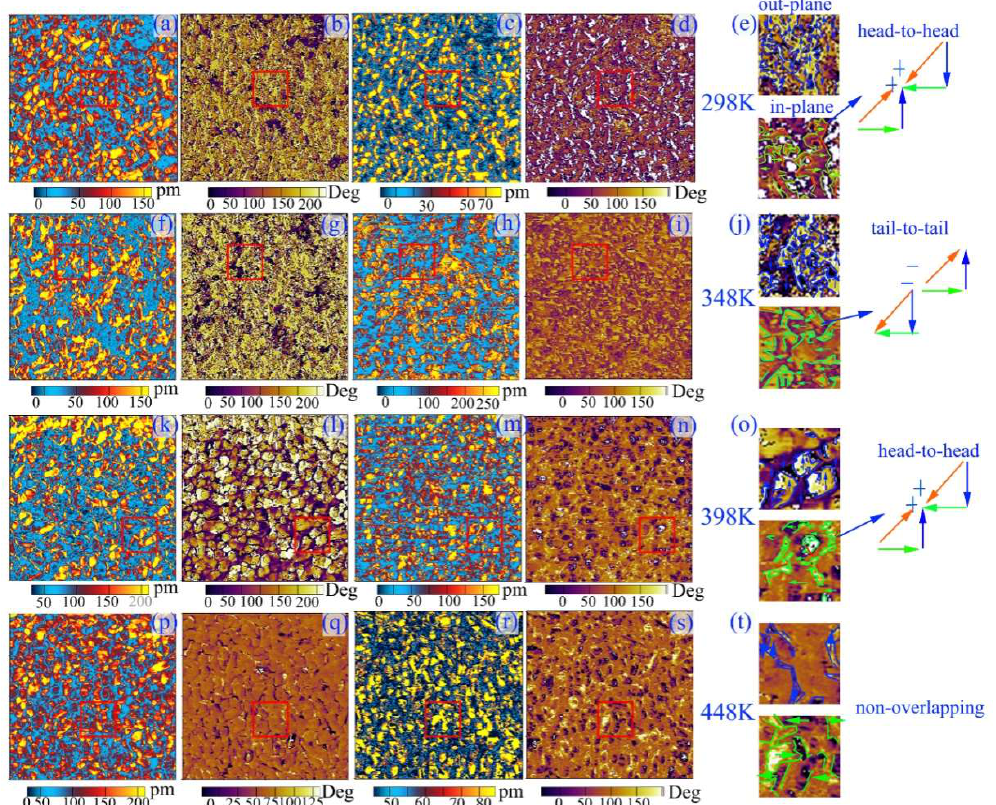
Figure 7. OP PFM amplitude image, OP PFM phase image, IP PFM amplitude images, IP PFM phase images and zoomed-in PFM images of specific region in red solid square of BNTM85 at elevated T :